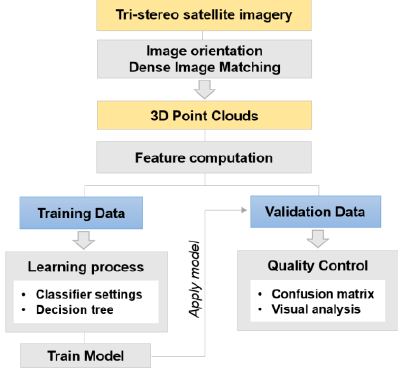
Figure 2. Overview of the general